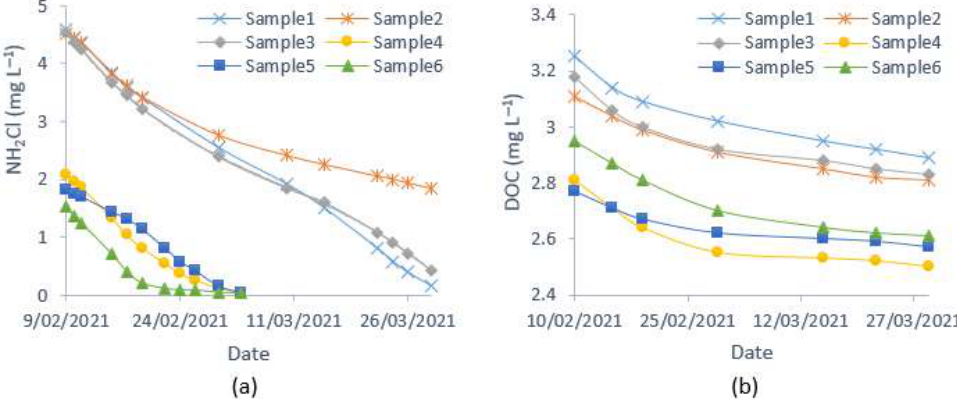
Figure 10. Observed water quality variations during the study period: ( a ) monochloramine and ( b )